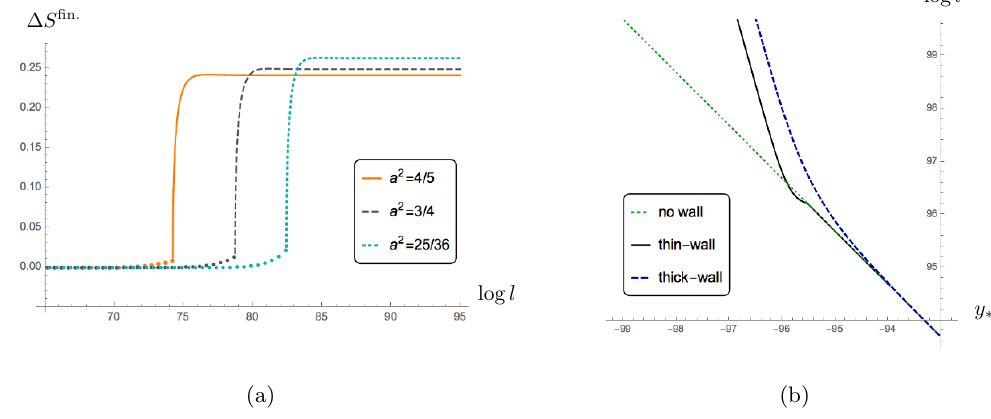
Figure 3 . (color online). (a) This plot illustrates di(cid:11)erent values between thin and thick-wall domain solutions, (cid:1) S (cid:12)n : = S thin (cid:0) S thick . We present two regions separated by a position of thick- wall. For the ranges, which denoted by circle lines, y < y DW , the thin-wall entropy are the same as the entanglement entropy of the pure AdS: S thin = S AdS . For y > y DW , (cid:1) S converges to speci(cid:12)c (cid:12)nite values for large l (cid:29) 1. (b) This plot illustrates the position of turning point for each di(cid:11)erent domain-wall solutions with a 2 = 51 =